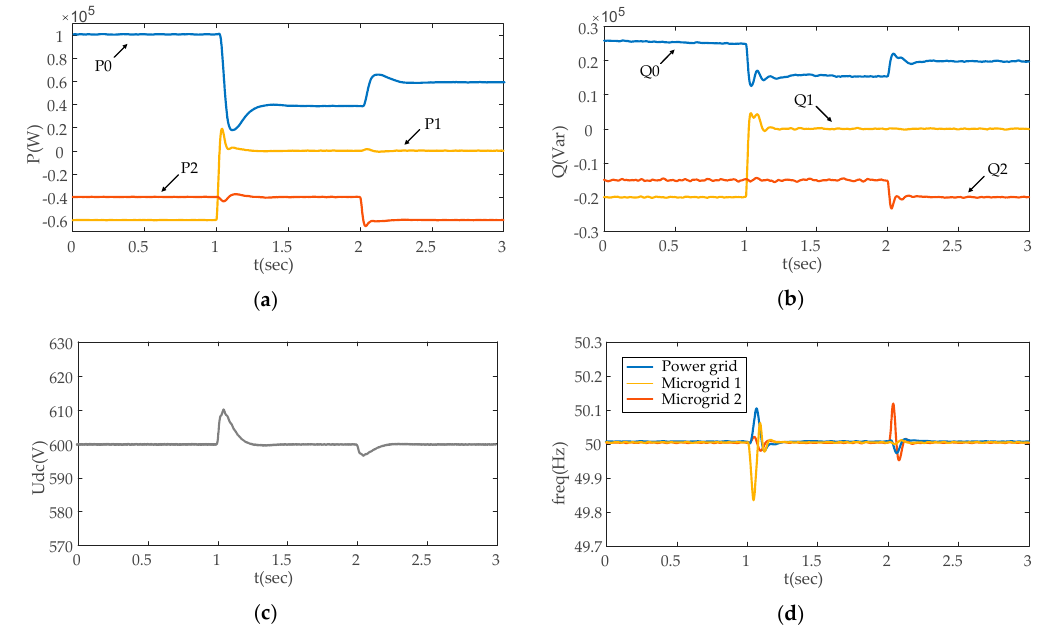
Figure 12. Simulation results of scenario 2: ( a ) active power curves; ( b ) reactive power curves; ( c ) DC-link voltage curves; and ( d ) frequency curves. t = 0–1 s